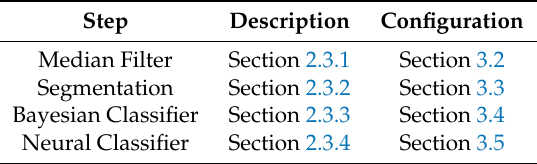
Table 1. Step description and